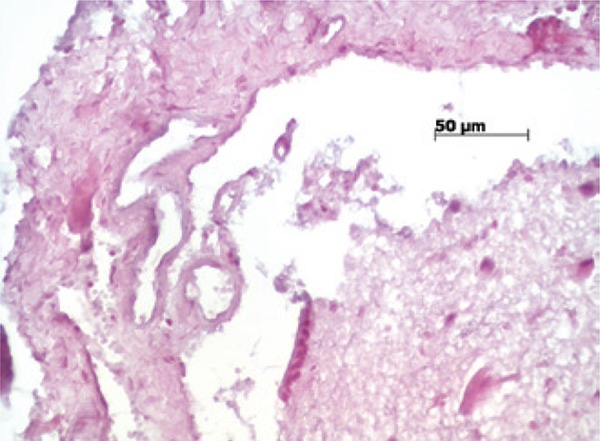
A fotomicrografia de um rato do Grupo Tela (hematoxilina-eosina, 400x) indicou a presença de neovascularização na dura-máter